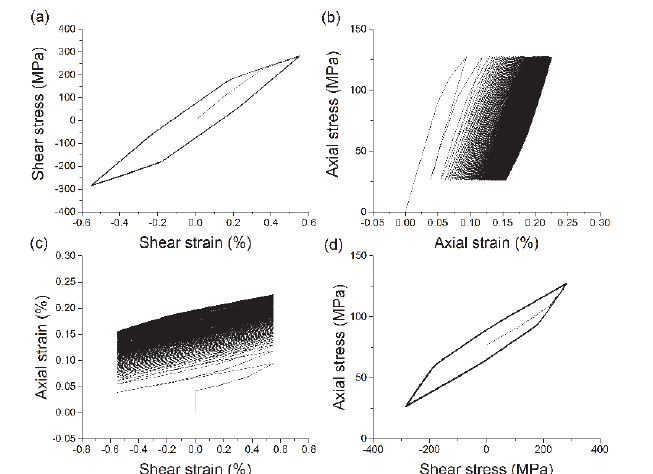
Figure 5: Predicted results of case 4 under linear path by the C-J-K, (a) shear stress-strain curve, (b) axial stress-strain curve, (c) strain path and (d) stress